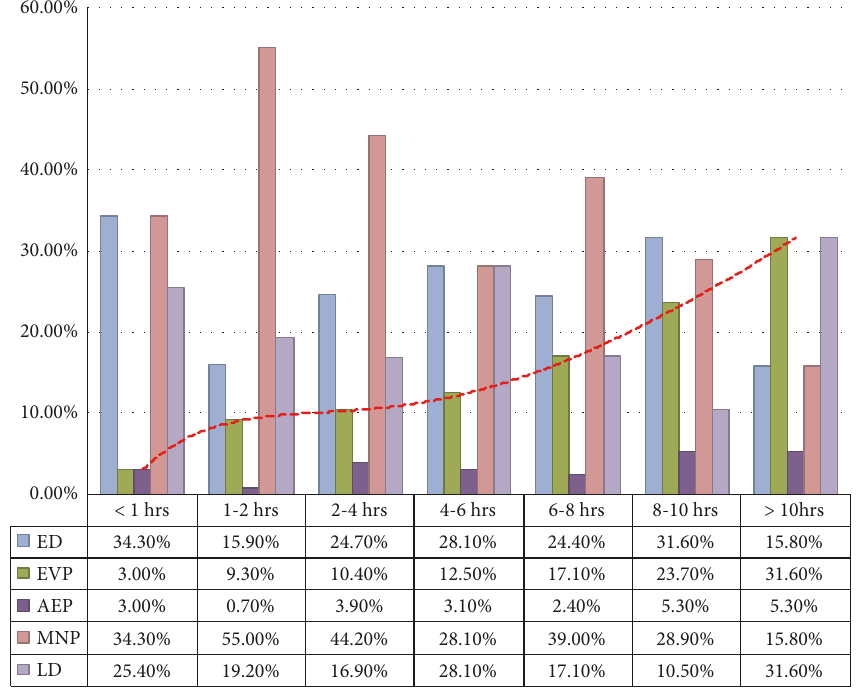
Figure 3: Crosstab of total travel time and departure time